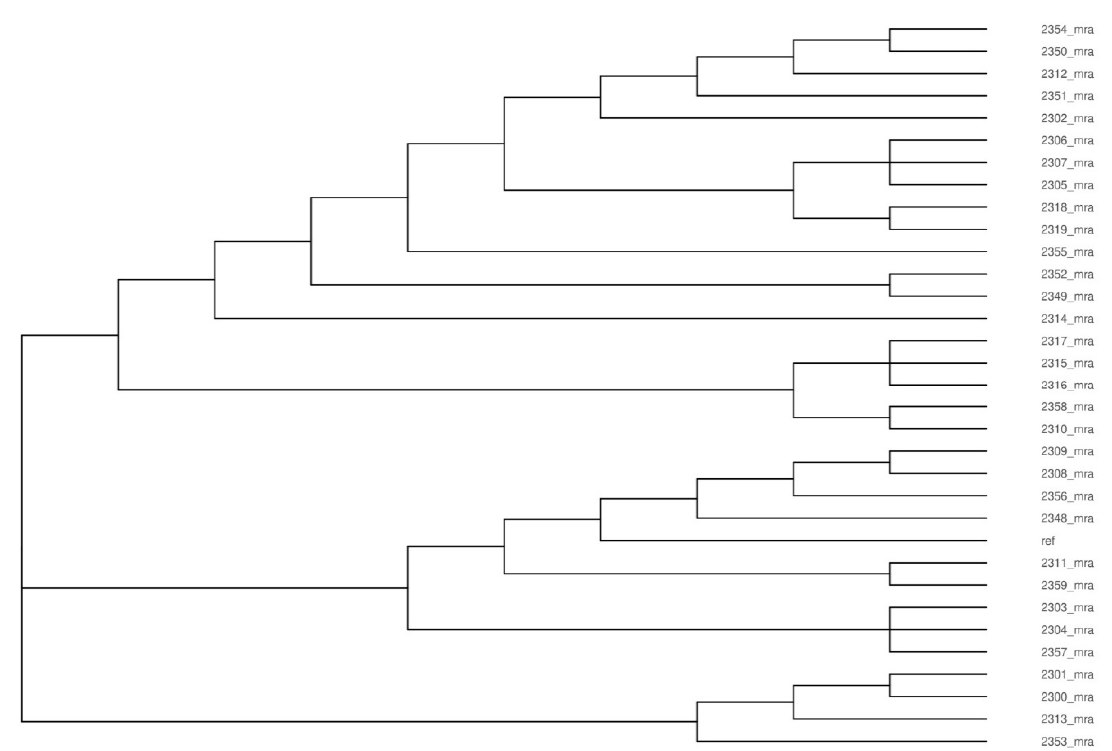
Figure 2. Parsnp dendrogram of the whole-genome alignment showing the similarity of L. mono- cytogenes isolates. All the Listeria genomic sequences were aligned to the reference genome, which is labeled as ‘ref’ on the plot